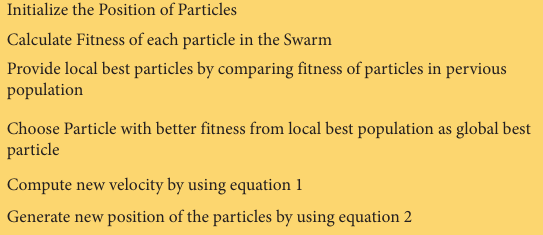
Figure 3: The optimization process of PSO.